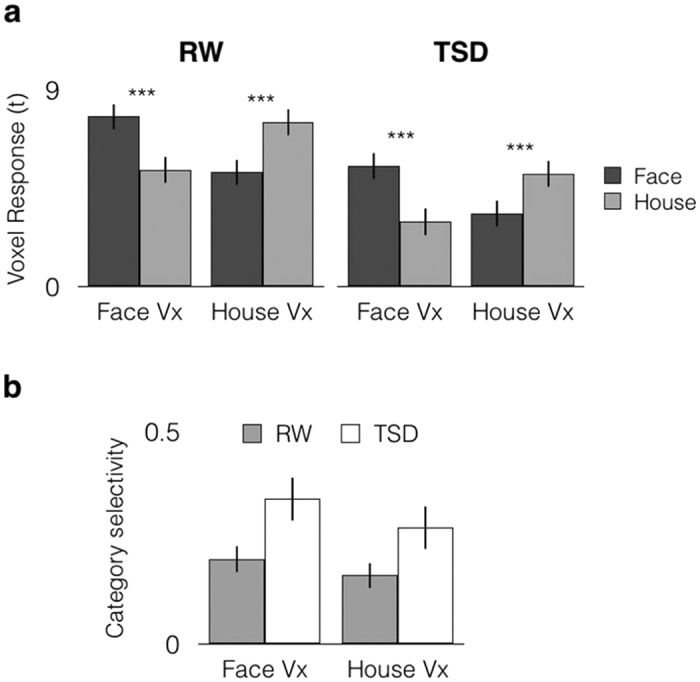
Category selective voxels responded more strongly to their preferred category and less strongly to their non-preferred category.(a) In both RW and TSD, face selective voxels (Face Vx) responded more strongly to isolated Face images (Face) than isolated House images (House), while house selective voxels (House Vx) responded more strongly to House than to Face. (b) Despite lower activation overall, normalized category-selectivity (tpreferred − tnon-preferred)/(tpreferred   + tnon-preferred) was preserved following sleep deprivation for both Face and House selective voxels. Error bars indicate +/−1 SEM. ***p < 0.001.